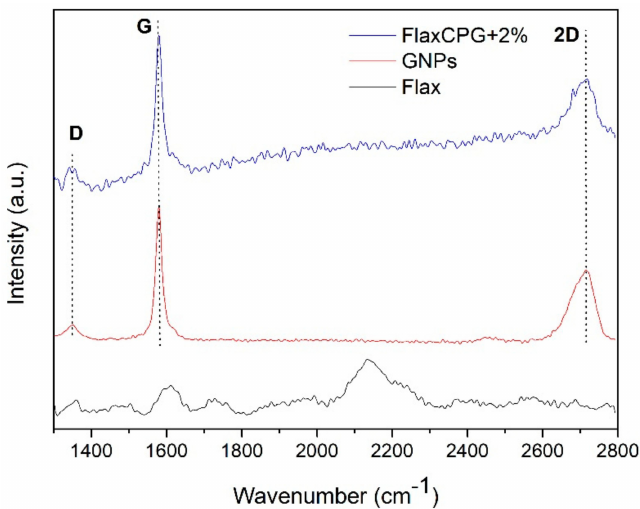
Figure 5. Raman spectra of the flax fabric (black), GNPs powder (red) and the developed FlaxCPG + 2% sample